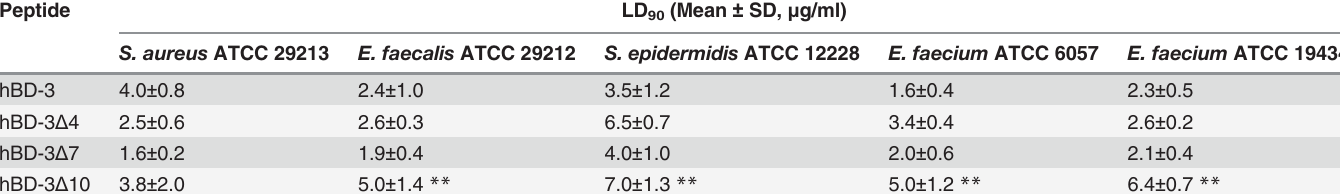
Table 2. Anti-bacteria activity of hBD-3 and its analogs.